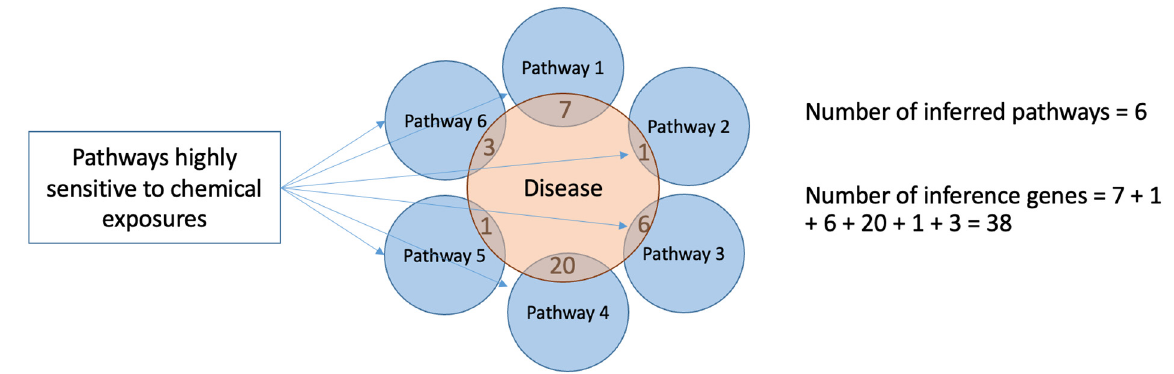
Figure 4. Two approaches for quantification of diseases’ sensitivity to chemical exposures. The first approach is based on the quantification of chemically sensitive pathways associated with the disease state—the number of inferred pathways. The figure illustrates an example, where a disease (testaceous circle) is associated with six inferred pathways (blue circles). The second approach counts the sum of genes from every pathway overlapping with the disease genes (number of inference genes).